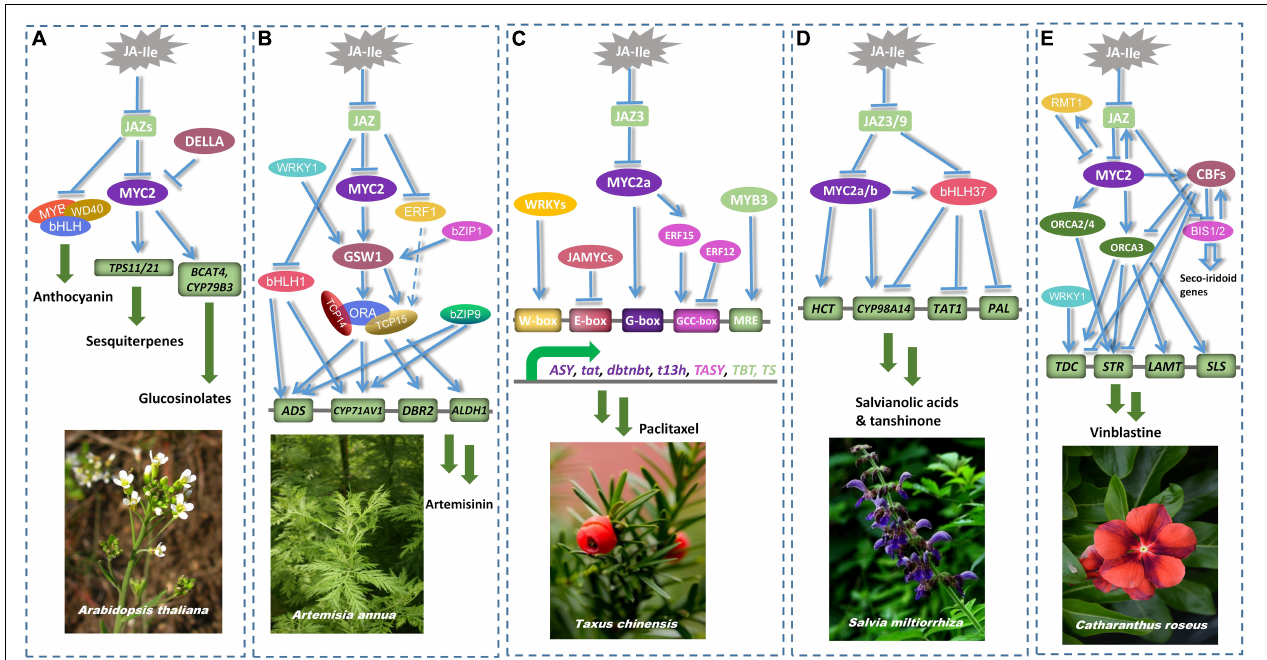
FIGURE 5 | MYC2 plays an important regulatory role in the formation of secondary metabolites in model plants. (A) AtMYC2 alone or together with the MYB/bHLH/WD40 complex regulates the expression of CYP79B3 , TPS11 , TPS21 and anthocyanins accumulation (Xu et al., 2013; Wang L. et al., 2019). (B) AaMYC2 up-regulates the expression of CYP71AV1 , by regulating the transcription of the glandular trichome-specific transcription factor AaGSW1 (Yu et al., 2012). AaMYC2 cooperates with ERFs, bHLHL1 and WRKY1 to jointly regulate the expression of ADS and DBR2 (Ma et al., 2018; Li L. et al., 2019). (C) TcMYC2a interacts with JAZ3 protein to regulate the expression of tat , dbtnbt , t13h , and coordinates with ERF12/15 to control the expression of TASY (Zhang M. et al., 2015; Zhang et al., 2018b). TcMYC2 and TcJAMYCs antagonistically regulate key genes of paclitaxel biosynthetic pathway (Lenka et al., 2015). (D) SmMYC2 interacts with SmJAZ3/9 to competitively control the expression of HCT6 and CYP98A14 (Zhou et al., 2016). bHLHL37 and MYC2 synergistically regulate the synthesis of salvianolic acid B. Unlike MYC2, bHLHL37 negatively regulates the expression of TAT1 , PAL1, and CYP98A14 (Du et al., 2018). (E) CrMYC2 affects the expression of downstream genes STR and TDC by regulating the transcription of ORCA2 and ORCA3 (Van der Fits and Memelink, 2001; Zhang et al., 2011). In contrast, the negative regulators CBF1 and CBF2 competitively bind to MYC2-targeted genes thereby repressing the expression of TIA pathway genes (Sui et al.,